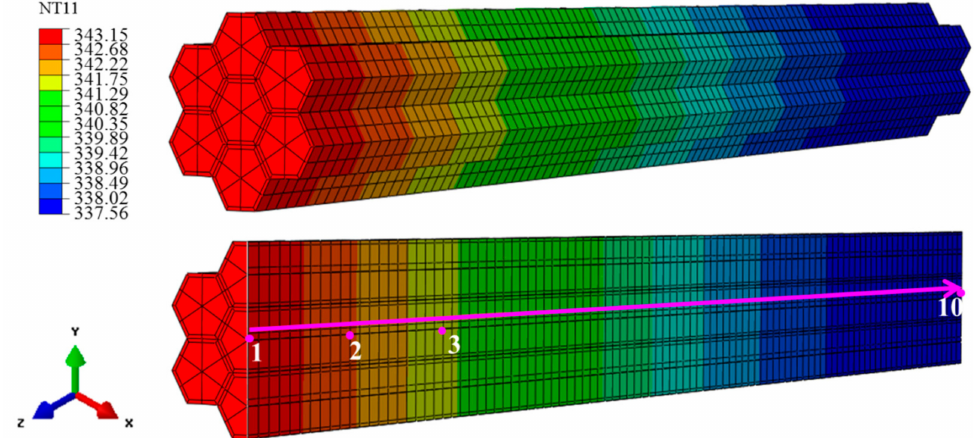
Figure 4. Diagram defining the temperature distribution of the model at 120 s, with temperature measurement points indicated by numerals. Red color indicates the location closest to the heating surface and blue color indicates the location farthest from the heating surface.